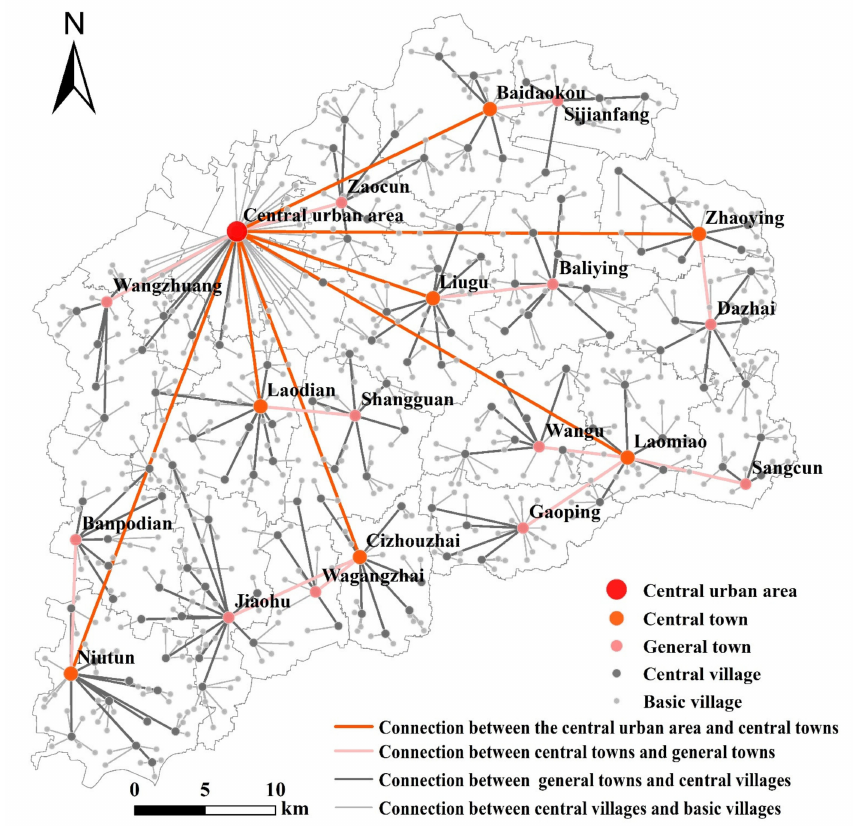
Figure 9. Optimization of the spatial hierarchical network structure of urban and rural